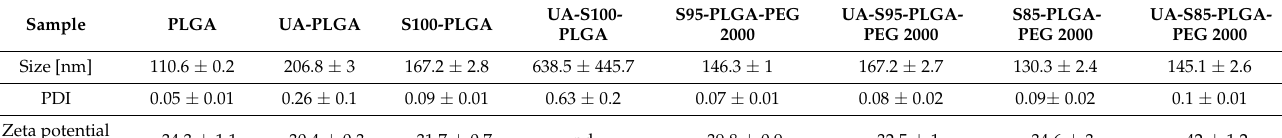
Table 2. Nanoparticles’ characterization: size, PDI, and zeta potential values; nd—not determined.